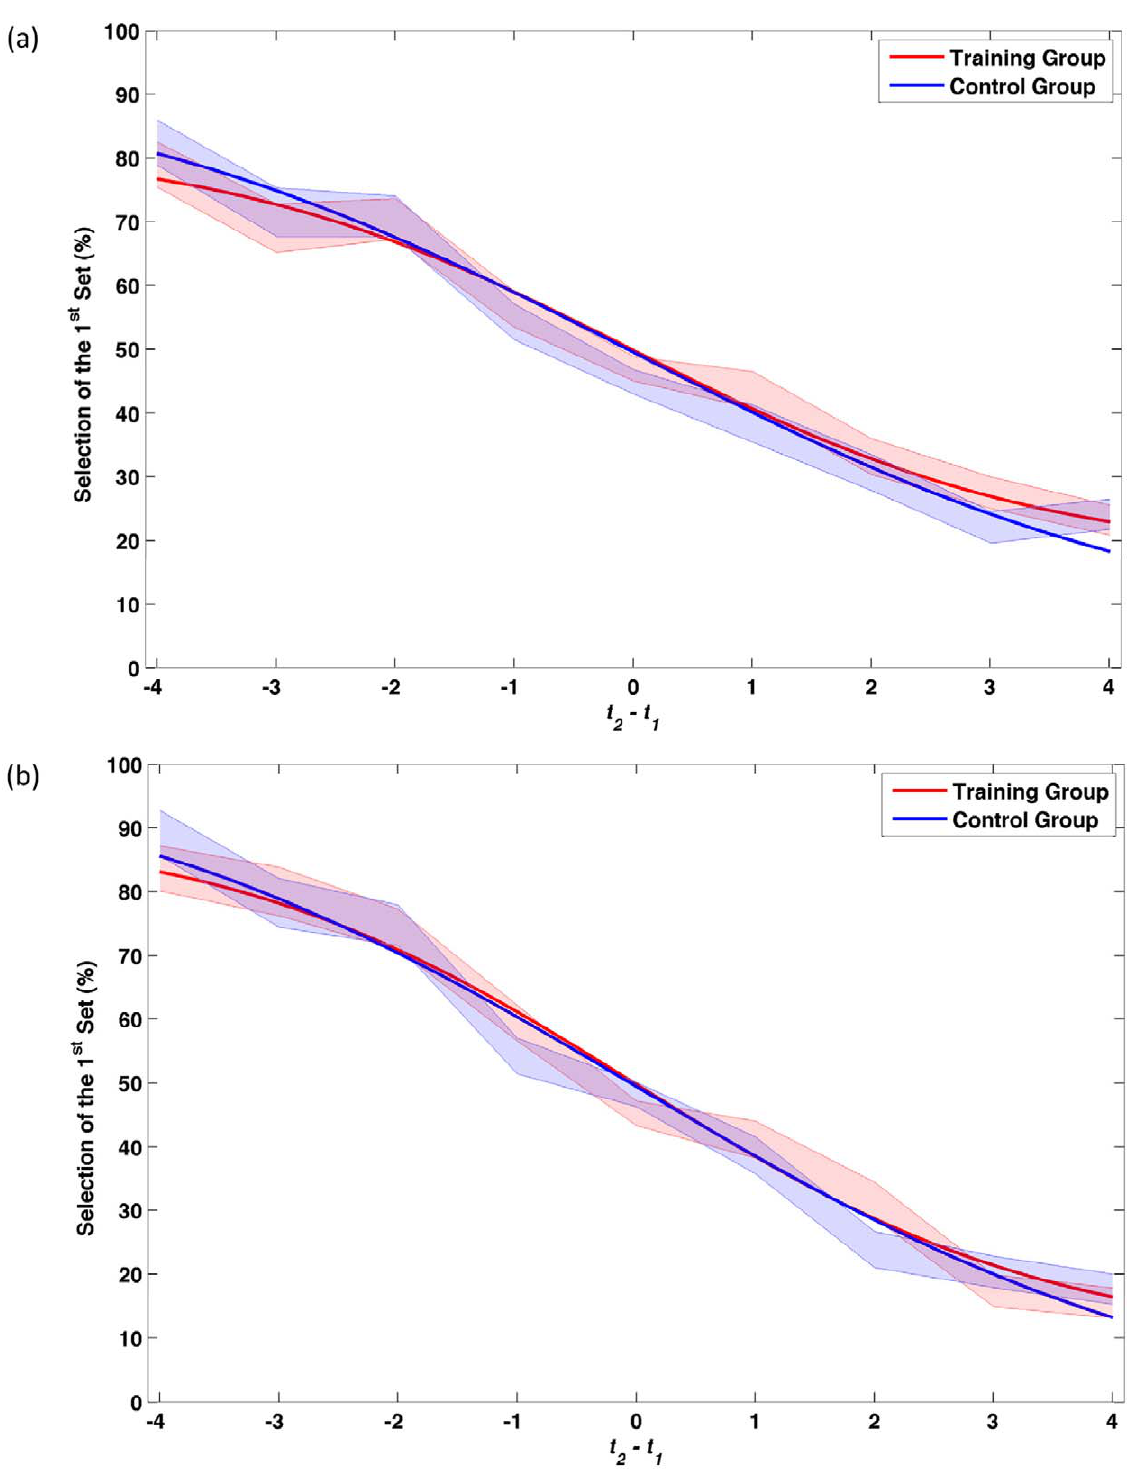
Figure 2. Percentage of selection of the 1 st set for veridical trials ( n 1 = n 2 and t 1 ? t 2 ). (a) 1 st testing session, (b) 2 nd testing session. The shaded areas represent one SD around the mean. doi:10.1371/journal.pone.0054098.g002 the two testing sessions were not biased differently towards either the first and second sets.